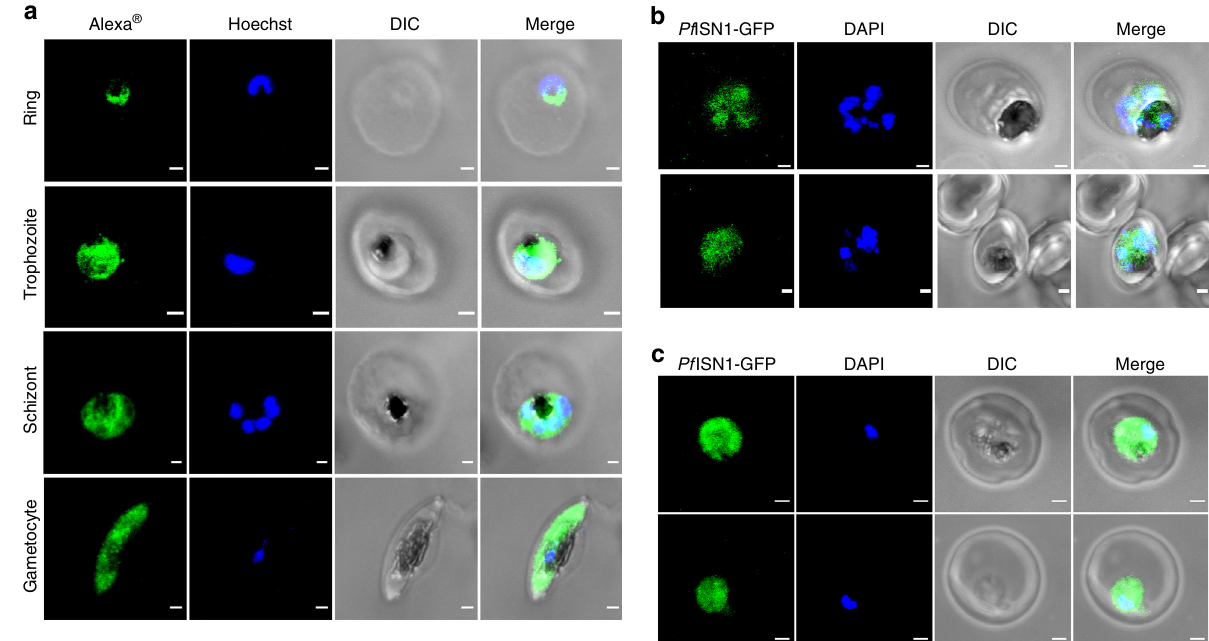
Fig. 1 Localization of ISN1 in Plasmodium . a Indirect immuno fl uorescence microscopy with anti- Pf ISN1 antibody on intraerythrocytic asexual (3D7 strain) and sexual (3D7A strain) stages of P. falciparum . The absence of signal from pre-immune control ruled out non-speci fi c binding (Supplementary Fig. 2). The antibody used was generated as described in “ Methods ” . Gametocytes were enriched as described in “ Methods ” . The experiment was repeated at least three times. Live-cell fl uorescence imaging of episomally expressed Pf ISN1-GFP fusion protein in 3D7_ Pf ISN1-GFP ( b ) and Pb ANKA_ Pf ISN1-GFP ( c ) parasites. Imaging of Pb ANKA_ Pf ISN1-GFP was performed at least three times with parasites collected from independent mice, and imaging of 3D7_ Pf ISN1- GFP was performed at least three times with parasites harvested from independent cultures. Scalebars correspond to 1 µ m. The stages indicated correspond only to ( a ). Source data are provided as a Source data fi